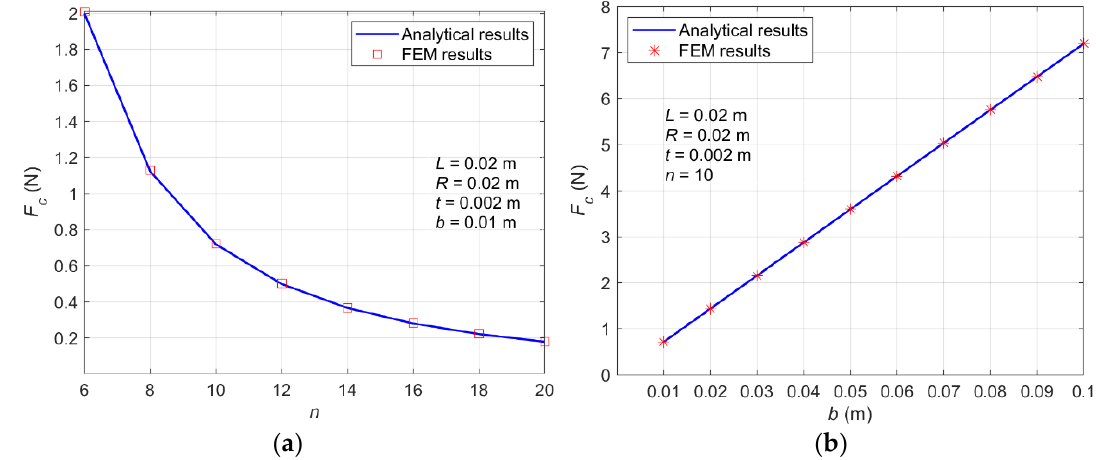
Figure 4. Parametric study of overall size: ( a ) F c vs. n , ( b ) F c vs. b.